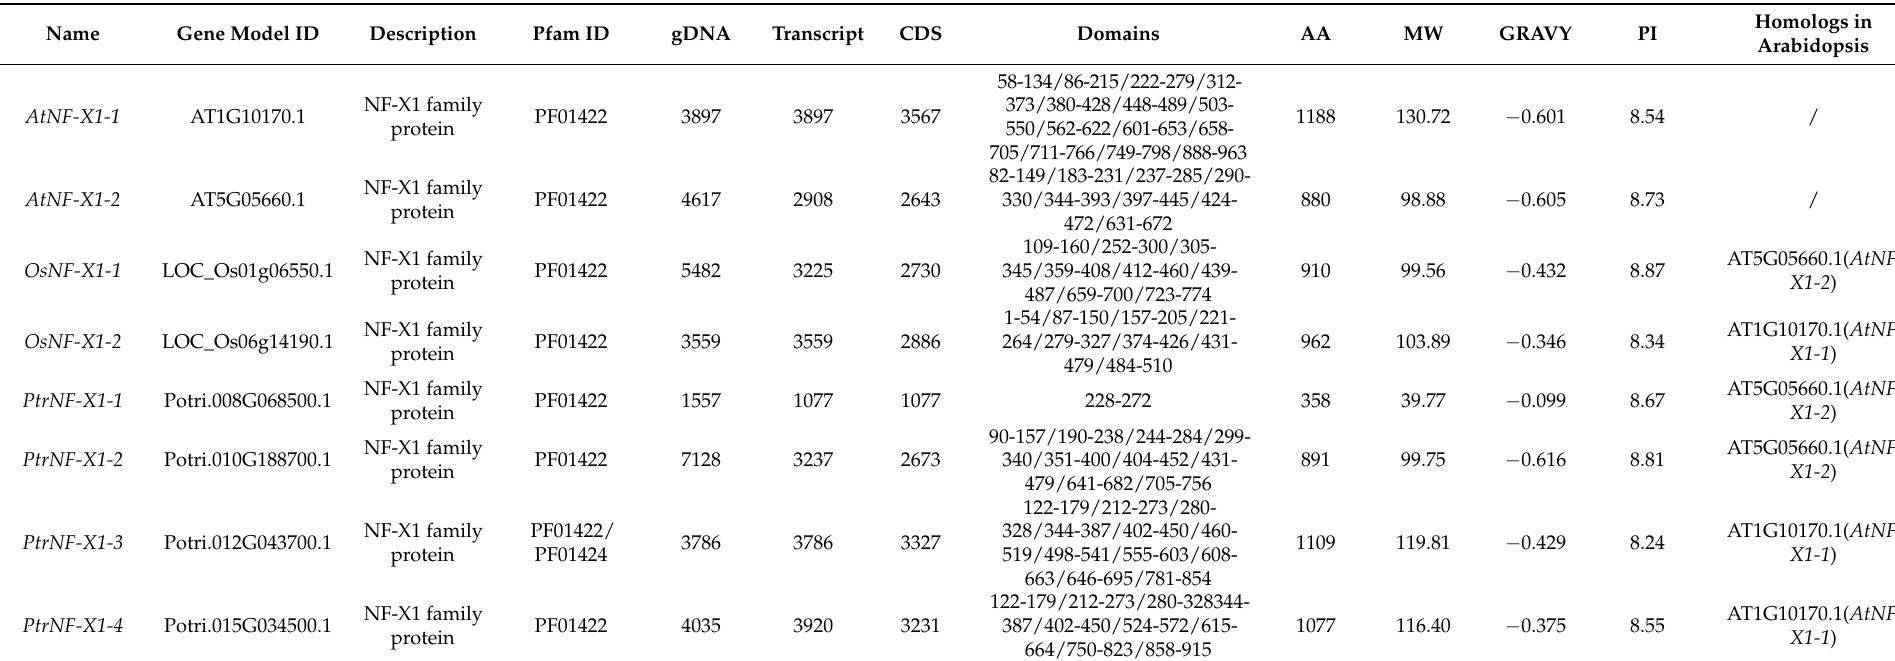
Table 1. Summary of NF-X1 in A. thaliana , O. sativa , and P. trichocarpa . AA, amino acid; MW, molecular weight (kDa); GRAVY: grand average of hydropathicity; PI: theoretical isoelectric